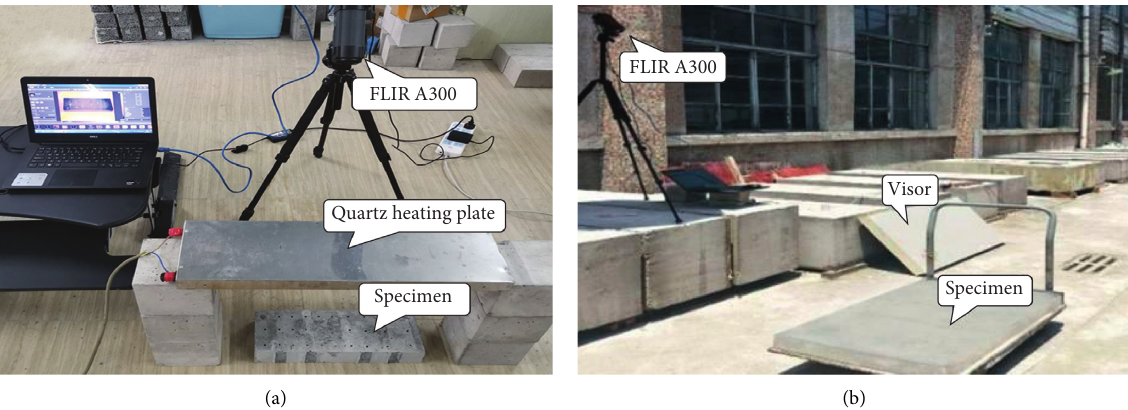
Figure 2: Equipment layout. (a) Pulse heating. (b) Solar heating.